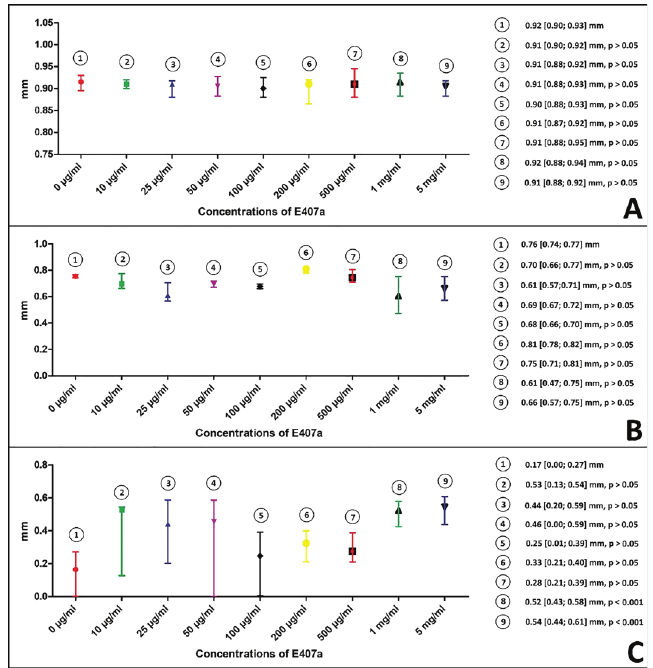
Figure 5 - Scratch assay was used to assess the motility of fibroblasts after exposure to semi-refined carrageenan (E407a) for 24a at the concentrations of 0-10 mg/ml. The width of cell- free areas was compared followed a formation of scratches by a pipette time after 0, 24 and 48 h, respectively. Semi-refined carrageenan at concentrations of 1 mg/ml and above statistically significantly reduced the motility of fibroblasts compared with